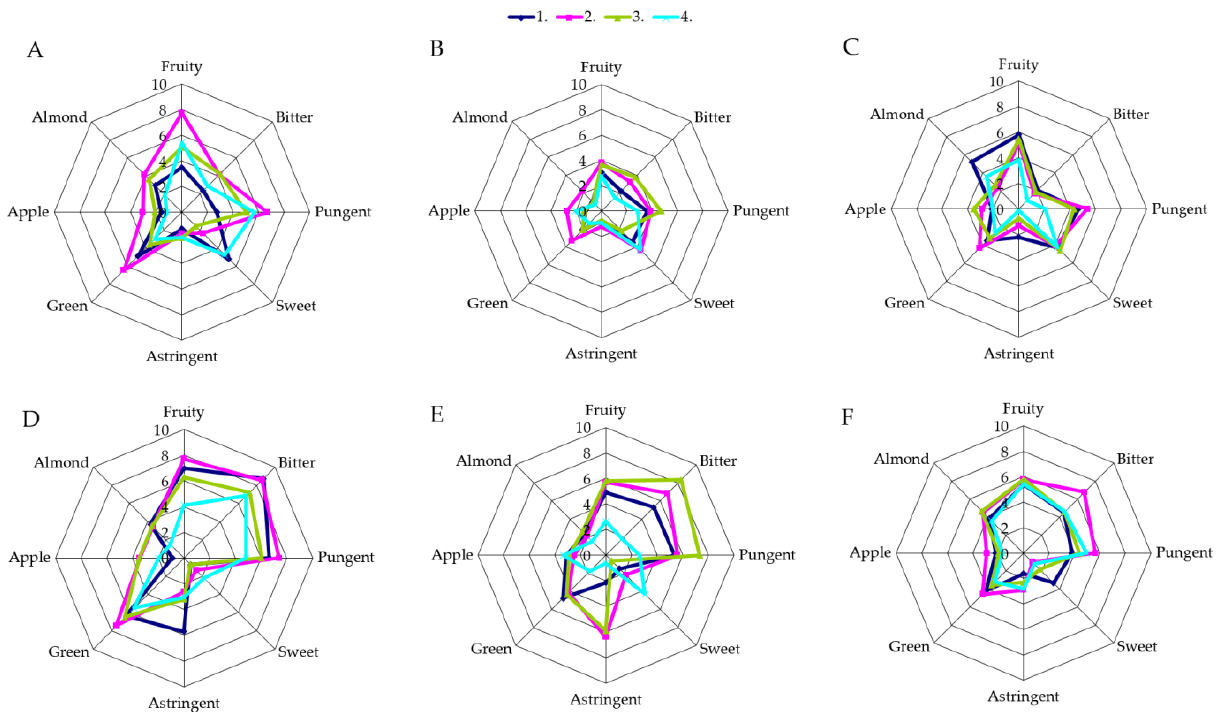
Figure 4. Sensory profile of Leccino virgin olive oils obtained in 3 successive crop years from the 2 distinct olive orchards at 4 harvest periods. ( A )—Kaštela 2010, ( B )—Kaštela 2011, ( C )—Kaštela 2012; ( D )—Šetanovac 2010, ( E )—Šetanovac, 2011, ( F )—Šetanovac 2012; 4 harvest periods—line colors 1–4 within each graph.